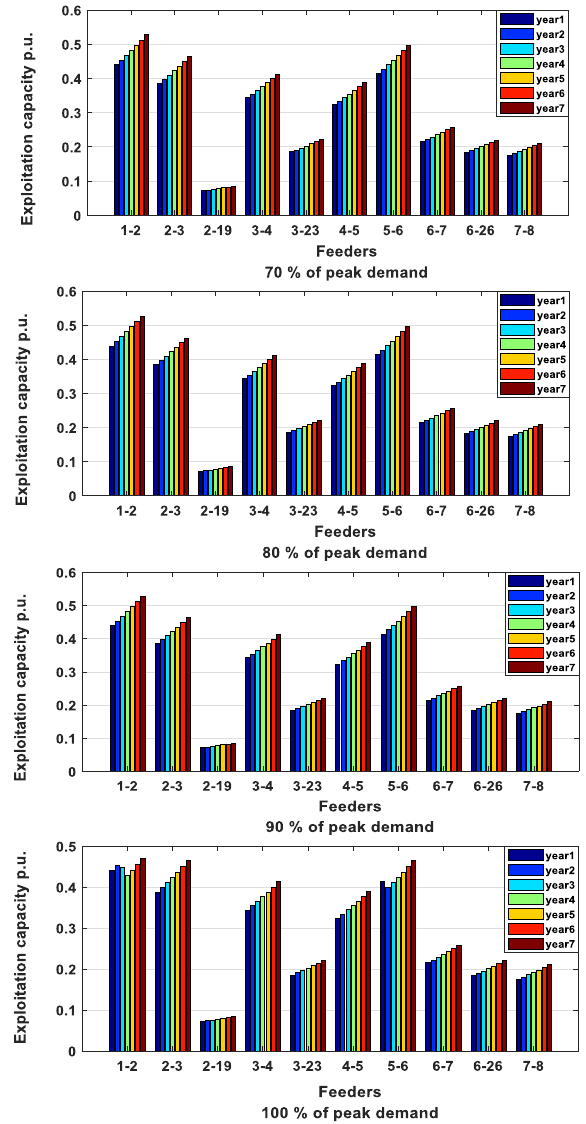
Figure 8. Annual variation of the exploitation capacity of the network in the four scenarios analyzed.